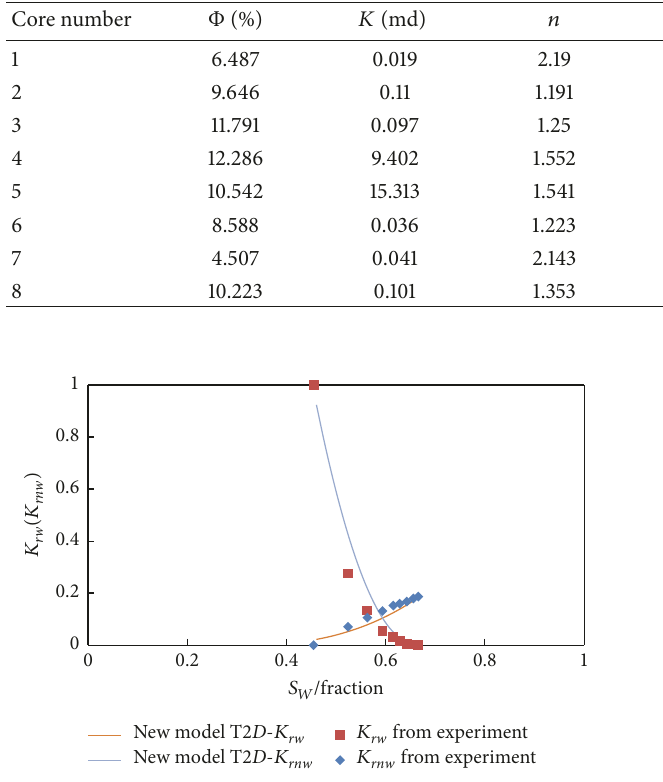
Figure 7: Transformation result contrast of Sample 5.